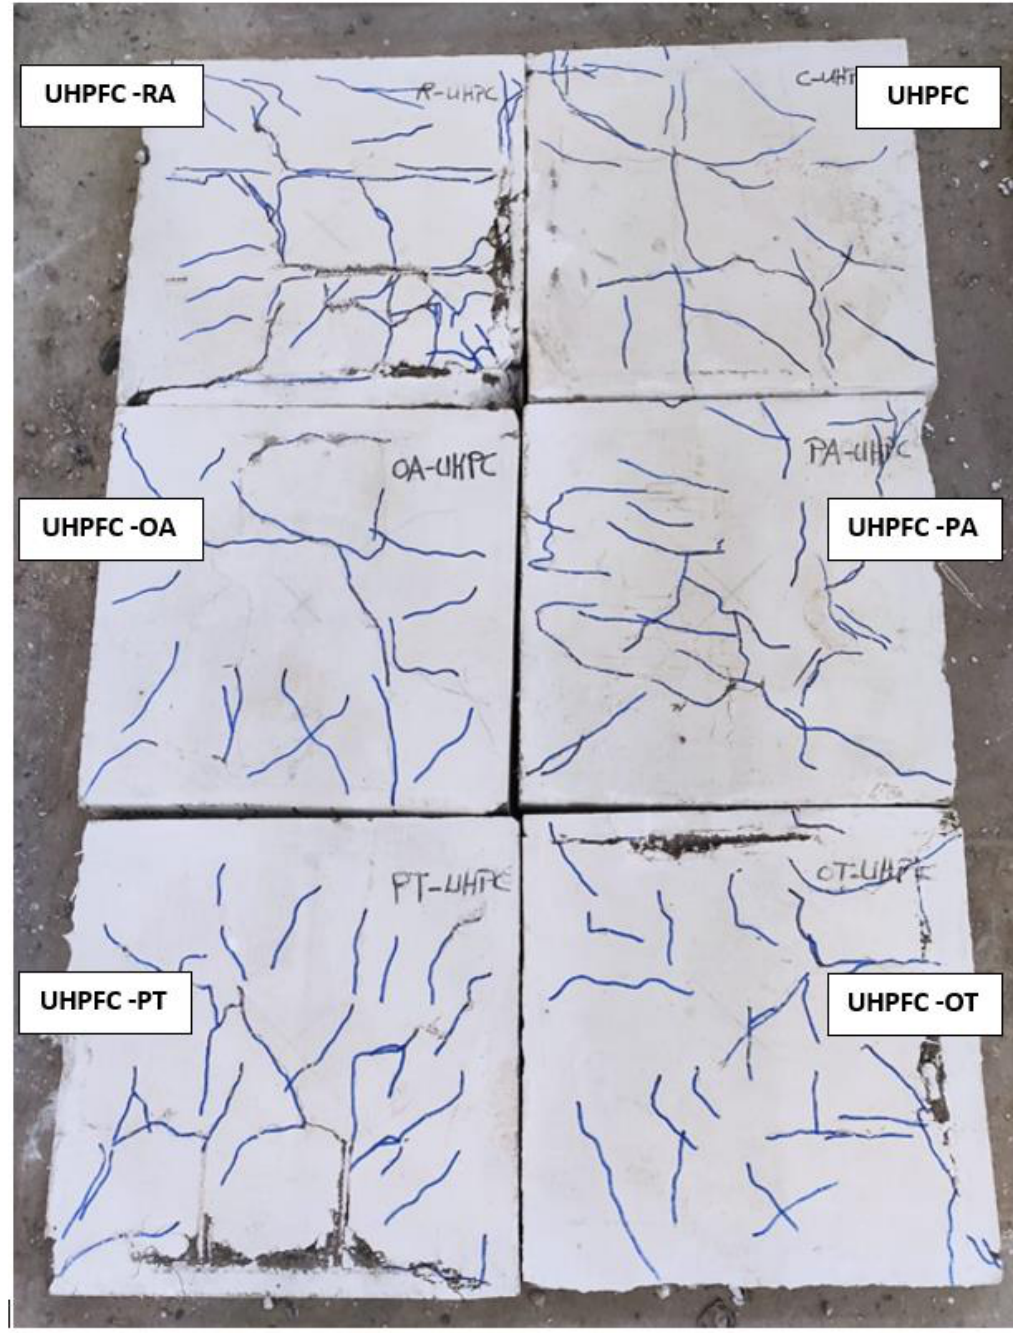
Figure 10. UHPFC specimens cracks.